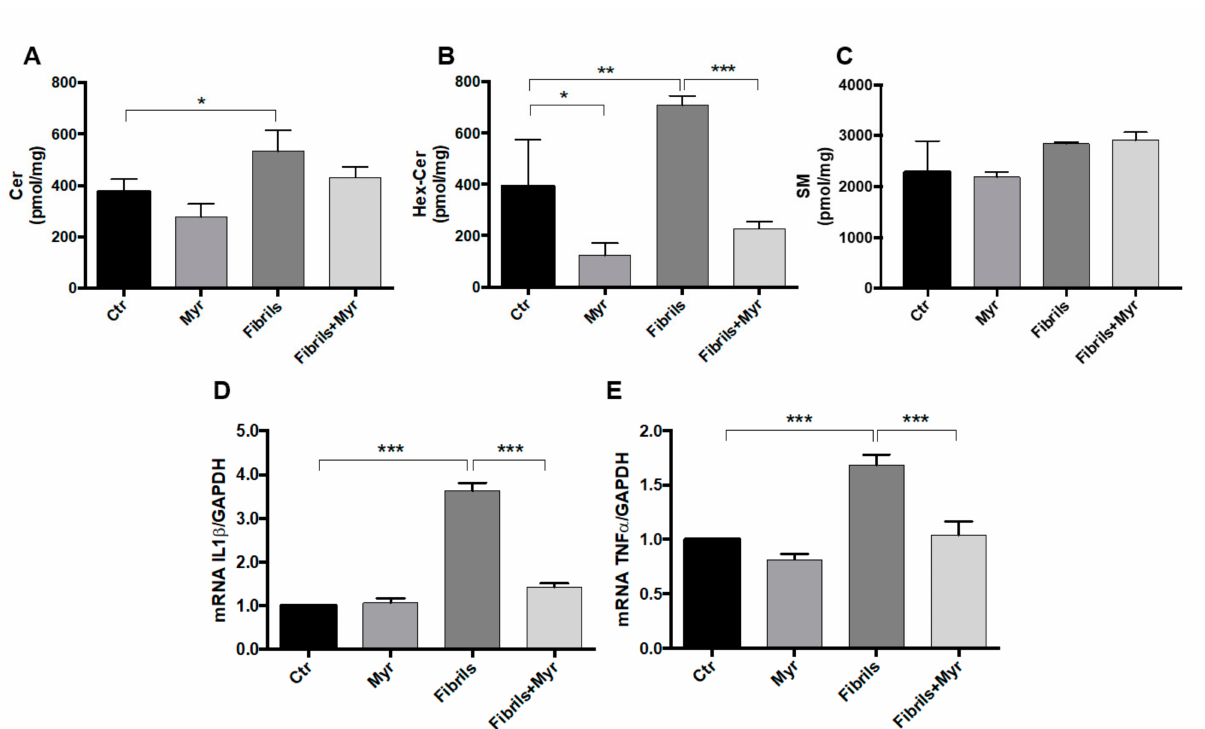
Figure 4. Myriocin reduces α -syn-induced inflammation in SH-SY5Y cells. ( A – C ) LC-MS measurement of ceramide (Cer), hexosylceramide (HexCer), and sphingomyelin (SM) levels and Myr effects in SH-SY5Y cells treated with 0.5 µ M α -syn fibrils for 24 h with or without 50 µ M Myr pretreatment. ( D , E ) Quantification of IL1- β and TNF α gene transcription by qRT-PCR in the PD cell model. GAPDH was used as a housekeeping gene. All data, derived from three independent experiments, are expressed as mean ± SEM (* p < 0.05; ** p < 0.01; *** p < 0.001); one-way ANOVA test followed by Bonferroni correction was used for all